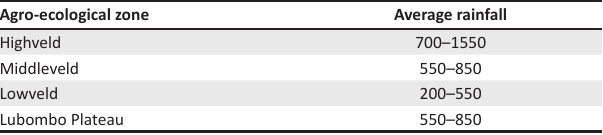
TABLE 1: Rainfall in ecological zones of Eswatini.